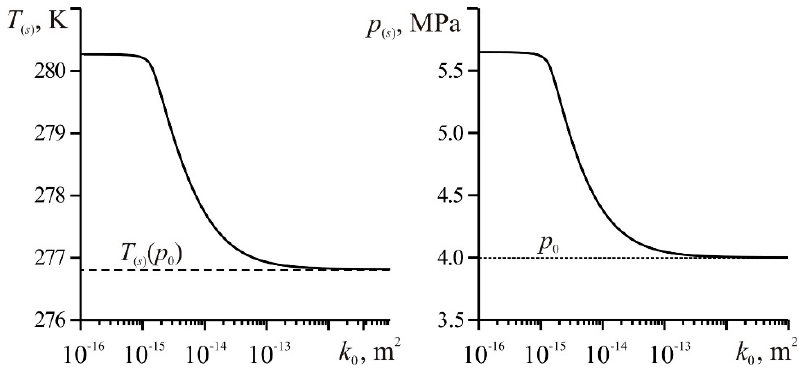
Figure 4. The change in temperature and pressure at the phase transition boundary depending on the permeability. S l 0 = 0.1, T 0 = 278 K, Q = 0.01 kg/(m ∙ s); other parameters correspond to Figure 2.